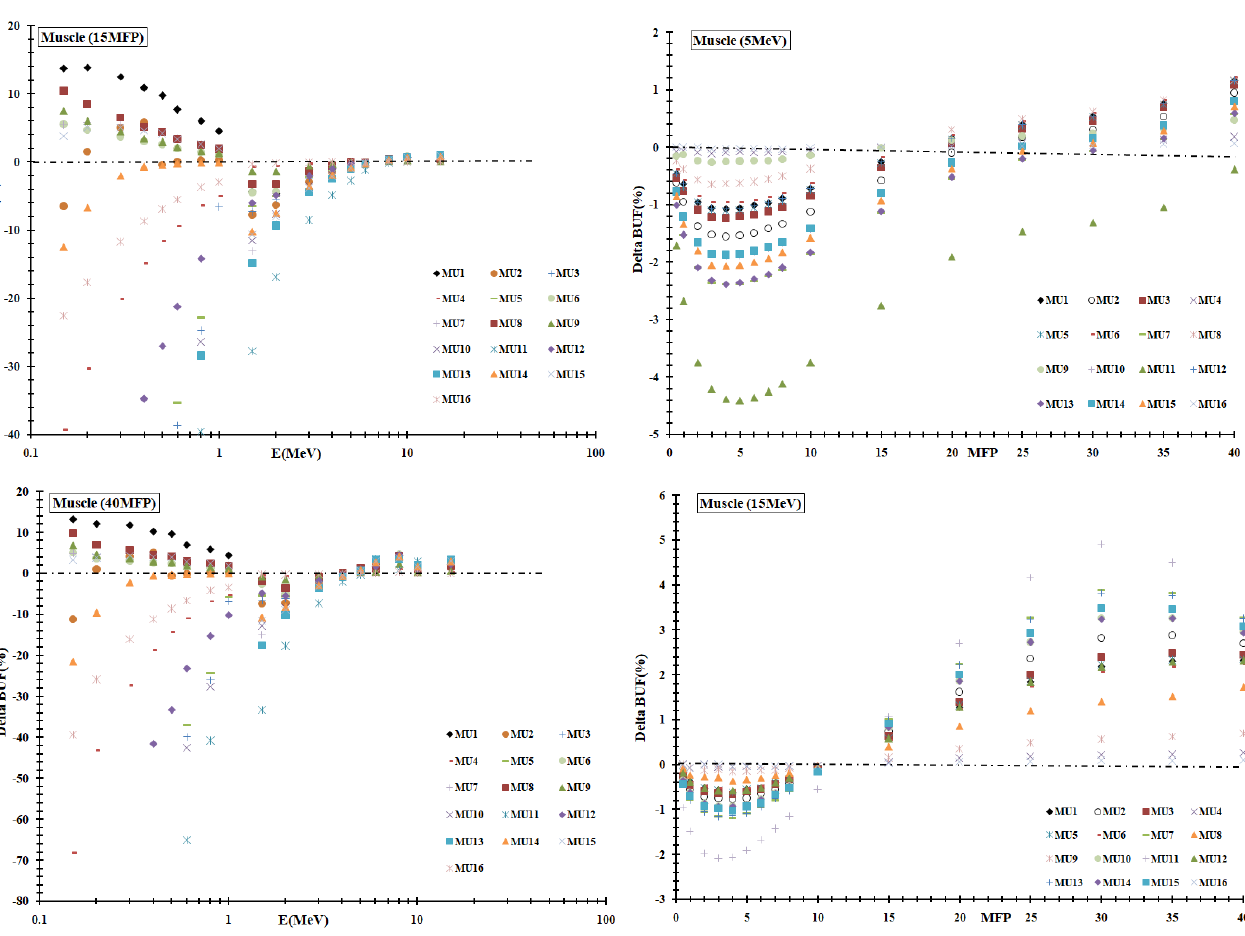
Figure 13. Relative percentage deviation of BUF values of substitute materials for muscle tissue as a function of: ( left side ) photon energy for fixed depths of 0.5, 15 and 40 mfp and ( right side ) depth for fixed photon energies of 0.5, 5 and 15